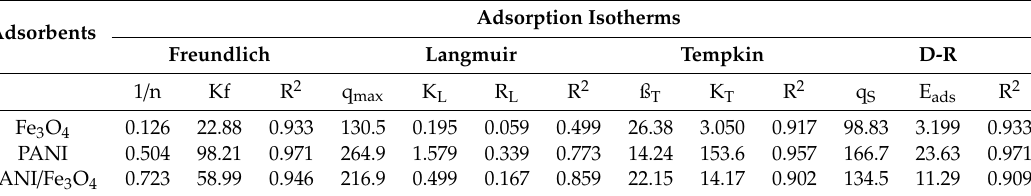
Table 2. Summary of parameters calculated from adsorption isotherms models.